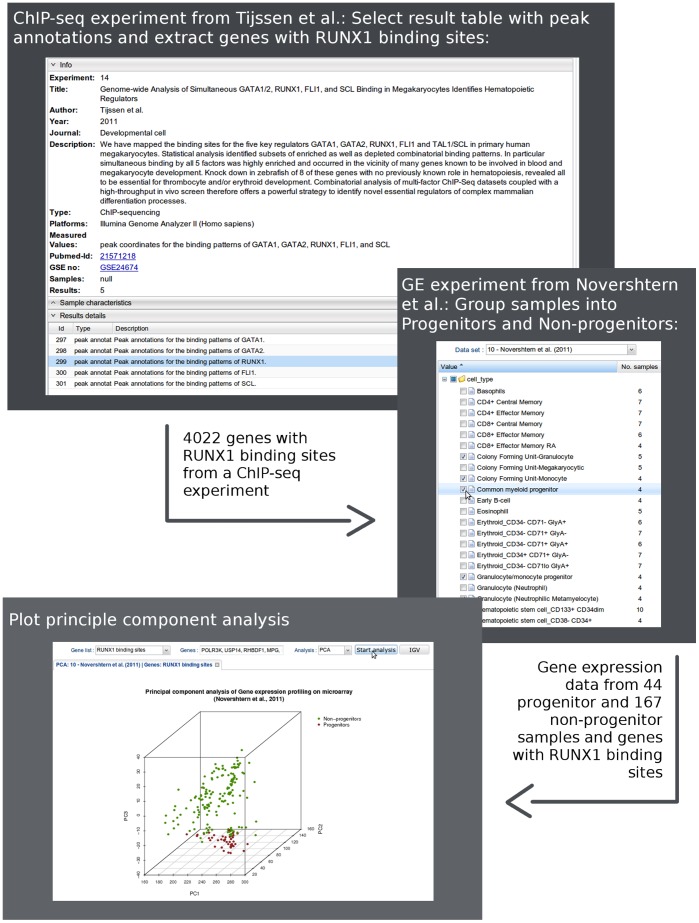
Usage of the LGA web interface. (Above)Experiment view with information on the integrated study [15] (above), sample characteristics (hidden, in the middle) and stored result tables (below). Genes with RUNX1 binding sites are copied from a table of peak annotations and stored as a gene list. (Middle) Groups of samples from [14] are defined in the analysis tab. (Below) Selecting the stored gene list (genes with RUNX1 binding sites) and performing principle component analysis on the selected groups of samples from [14].